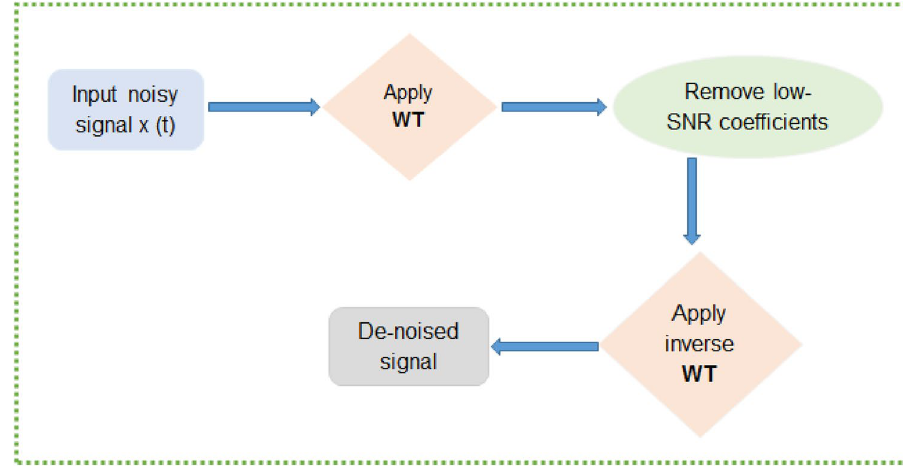
Fig. 1 Flowchart of process of denoising by wavelet transforms adopted in this